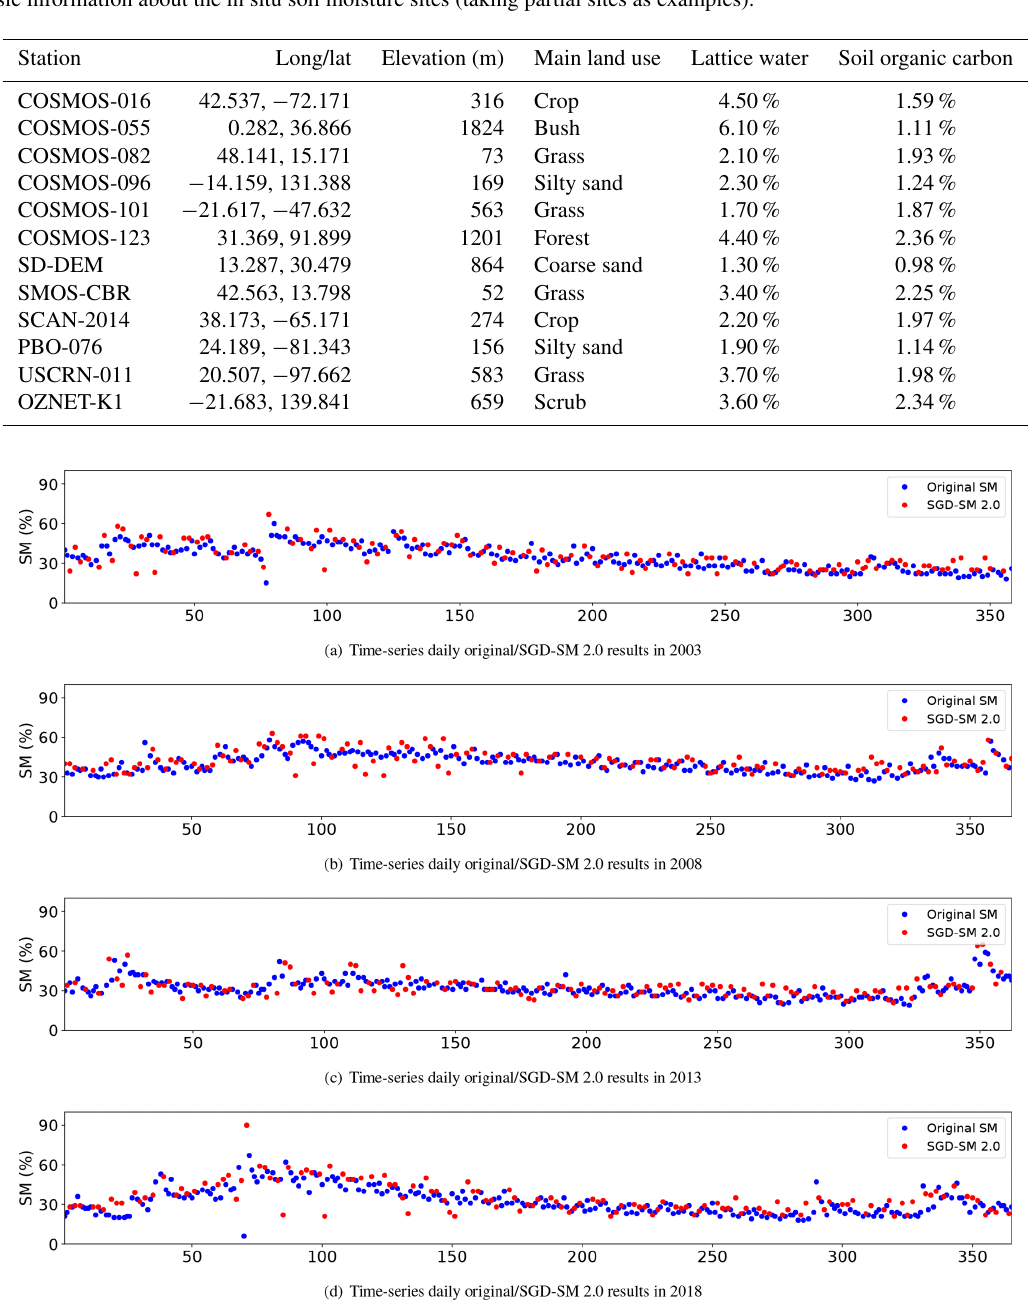
Figure 9. Time-series daily original/SGD-SM 2.0 results of the location (10.125 ◦ S, 42.625 ◦ W) in 2003, 2008, 2013 and